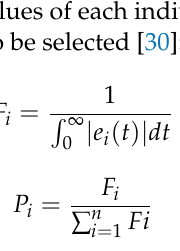
Figure 7. Flow of the GA.